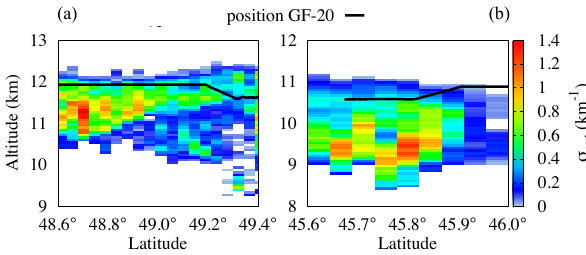
Fig. 9. Altitude of the GF20 aircraft during selected legs of 16 May 2007 (a) and 25 May 2007 (b) . The extinction profiles cor- respond to CALIOP products at 1km horizontal